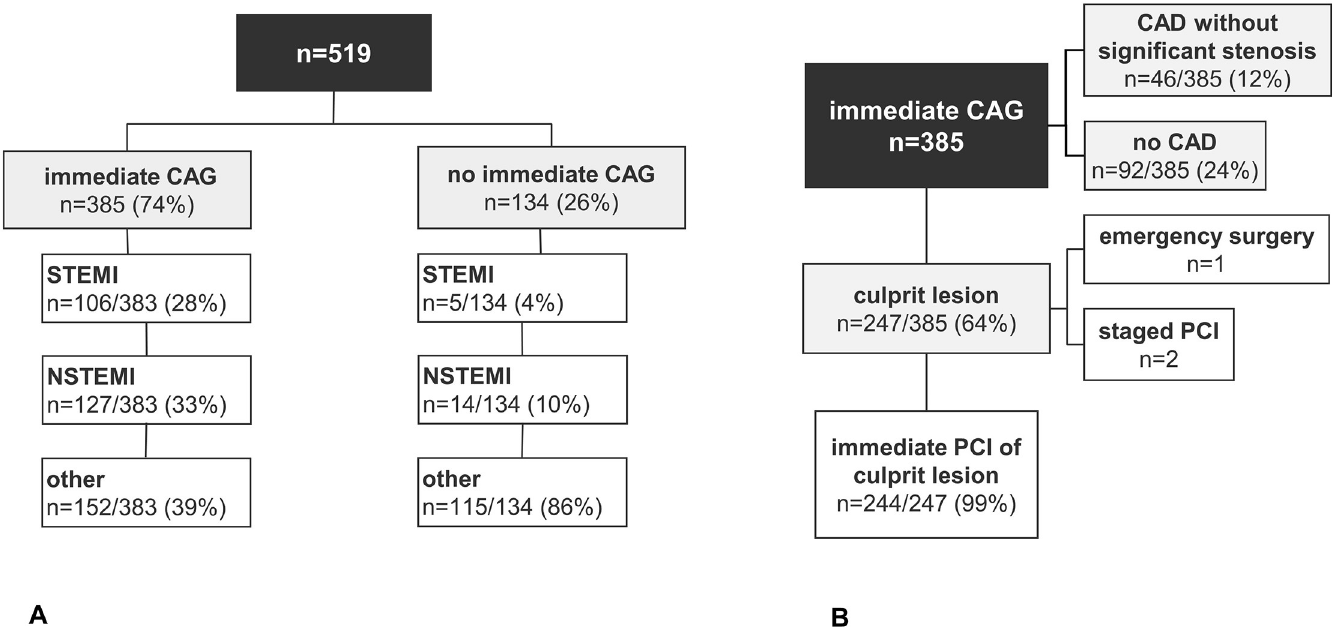
Fig 1. Patient flow